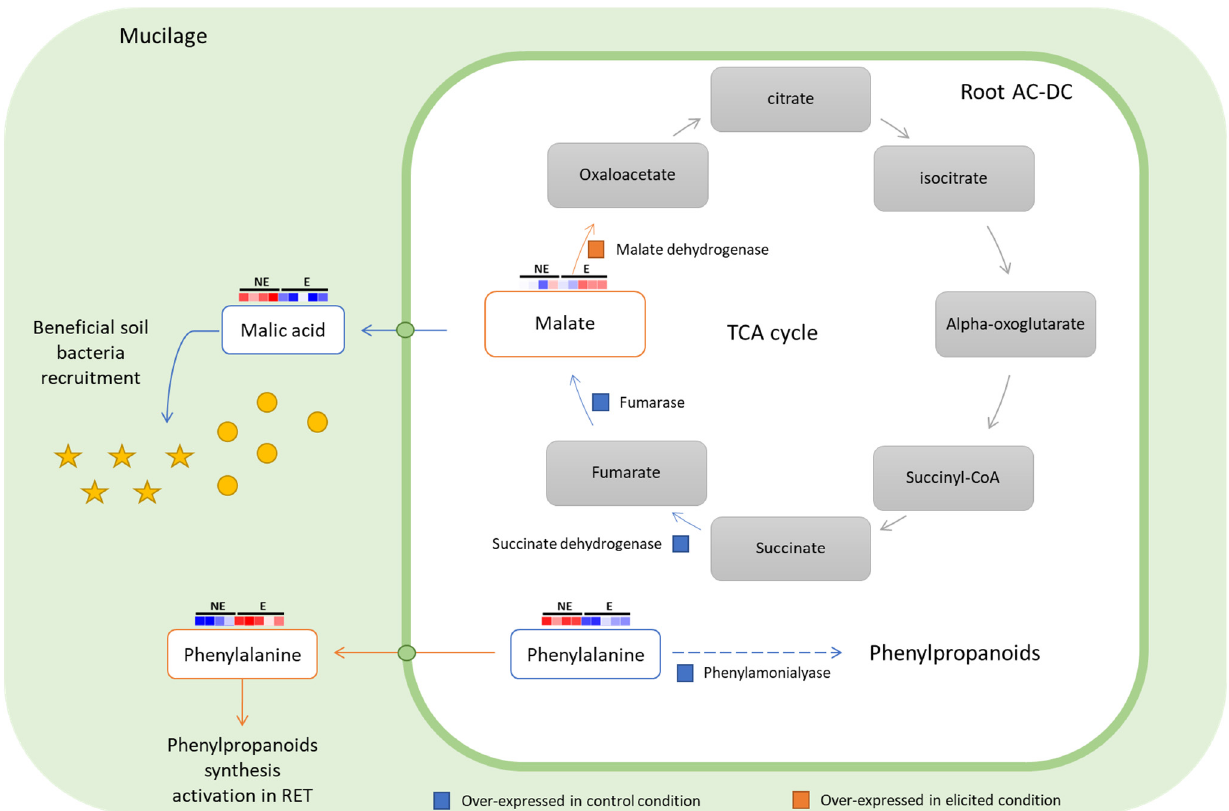
Figure 6. Malate and phenylalanine use in root AC-DC and mucilage is modified upon PEP-13 elicitation. The tricarboxylic acid (TCA) cycle in root AC-DC seems to be modified in control conditions (NE: non-elicited) in order to transfer malic acid in the mucilage. Upon elicitation with PEP-13 (E), a malate deshydrogenase is over-expressed, enabling the conversion of malate in oxaloacetate during the TCA cycle. In control conditions, phenylalanine is found in root AC-DC along with an over-expressed phenylamonialyase. These two actors might induce the synthesis of phenylpropanoids in root AC-DC. Upon elicitation, phenylalanine is found in mucilage and might be used as a defense signal for other cells and roots by activating their phenylpropanoid synthesis. Yellow circles and stars represent beneficial soil bacteria.